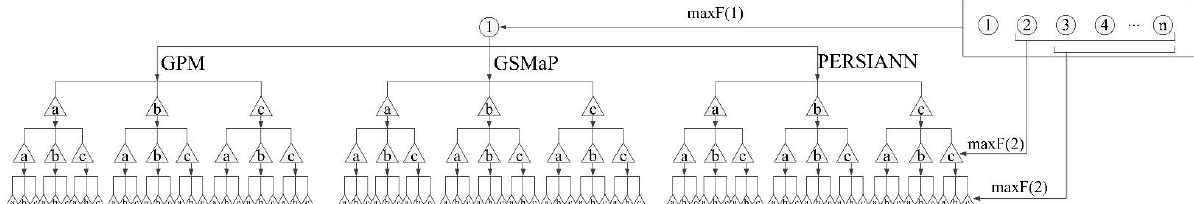
Figure 3. Schematic diagram of joint information entropy calculated using layer-by-layer algorithm based on satellite-observed precipitation deviations (a, b and c are three different precipitation deviation values for different days).